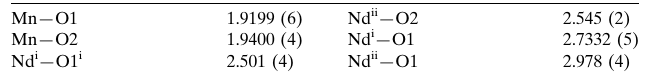
Selected bond lengths (A˚